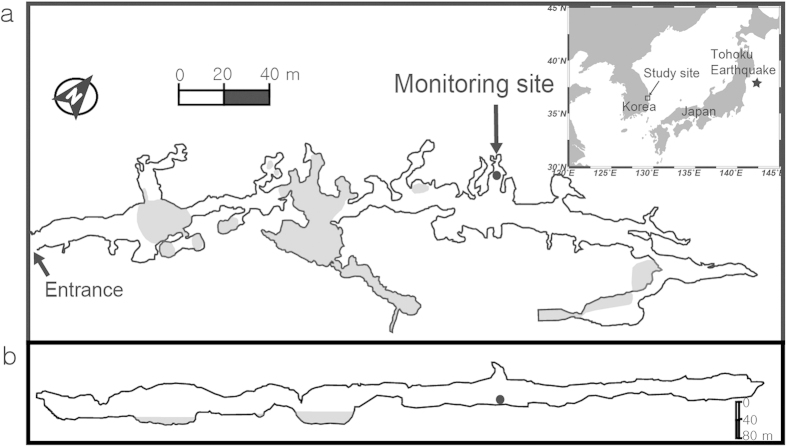
Location of the radon isotopes (222Rn and 220Rn) monitoring site in Seongryu Cave.(a) Location of the radon isotopes monitoring site and the layout of the cave. Grey areas denote lakes areas where the cave bottom is covered by water. (b) Vertical cross-section of the cave. This map was modified from Oh and Kim16.